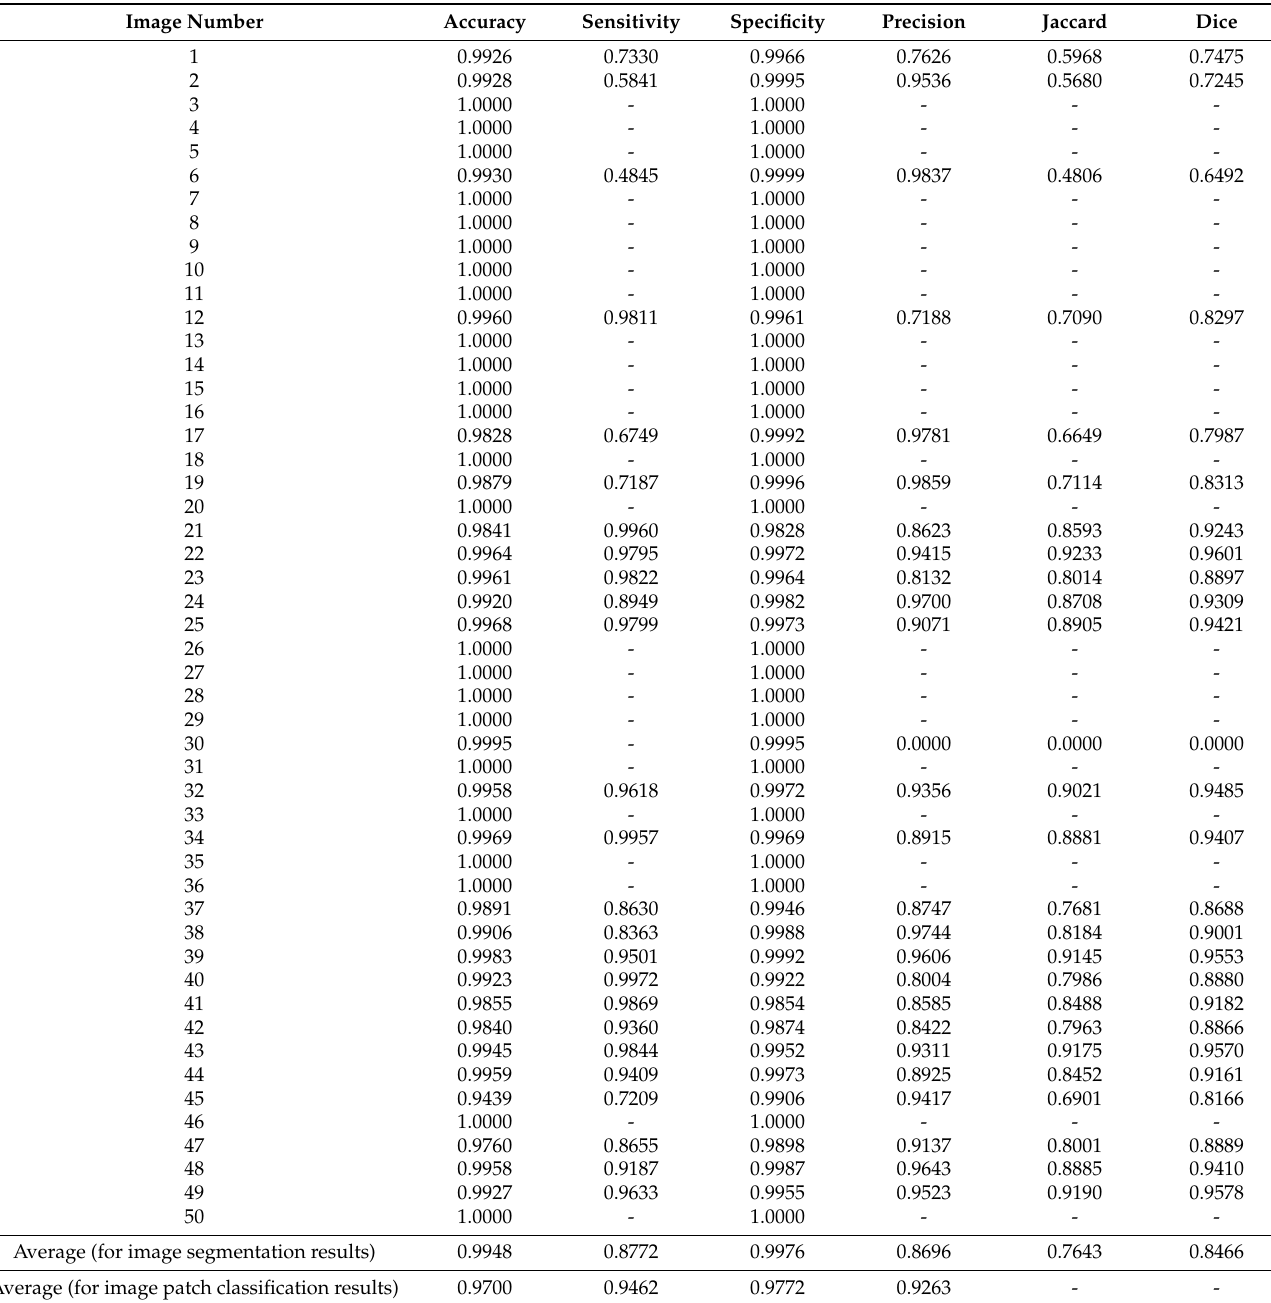
Table 1. Performance of the proposed method (results from the testing